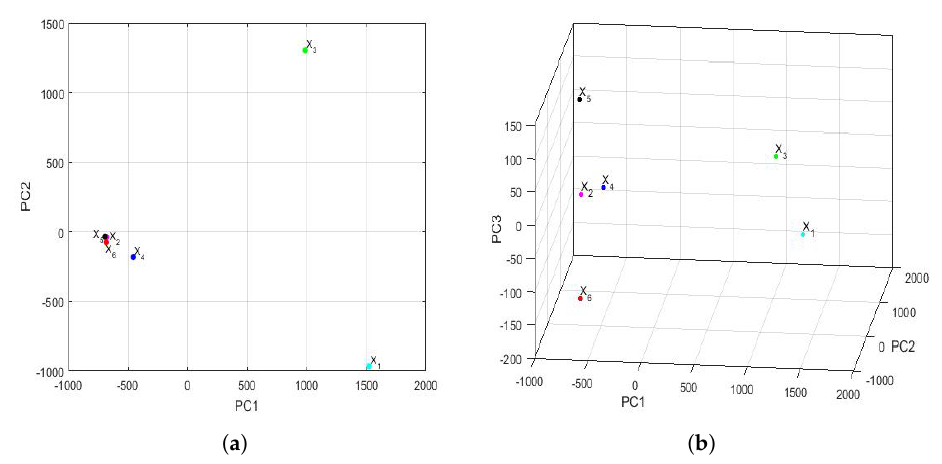
Figure 15. Location of the feature vectors of the variables with respect to the first two and three principal components: X 1 (2015), . . ., X 6 (2020). ( a ) Feature vectors: first 2 principal components. ( b ) Feature vectors: first 3 principal components.